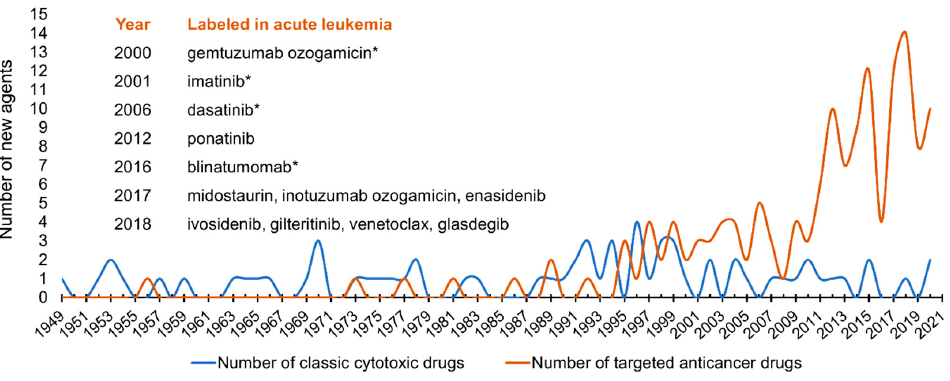
Figure 1. Emergence of anticancer drugs as approved by the United States Food and Drug Ad- ministration. Small-molecule targeted agents with acquired label in acute leukemia are specifically indicated. Agents with on-label approval in pediatric leukemia are marked with asterisk (*).